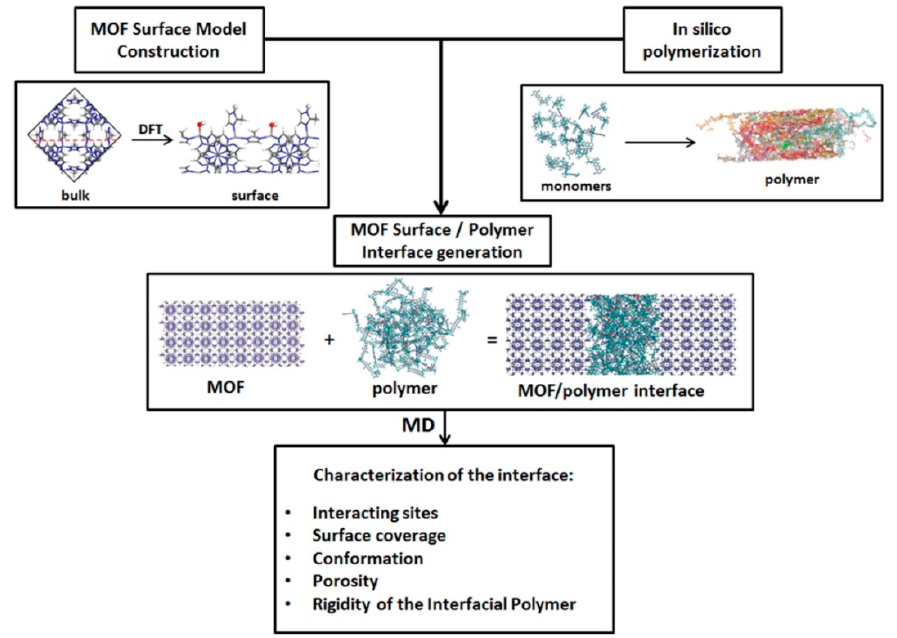
Figure 8. Methodology developed for the generation of the MOF/polymer interface and its characterization. Reprinted from Ref. [103] with permission from American Chemical